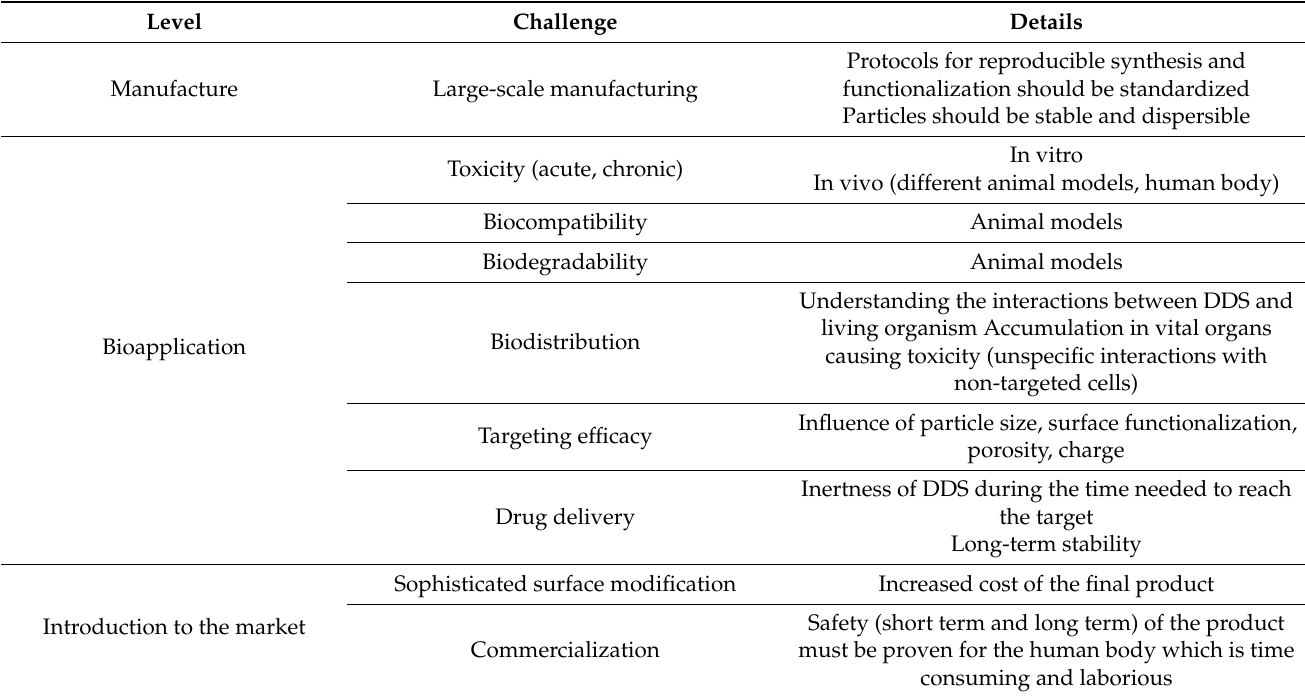
Table 6. Challenges related to the application of mesoporous material-based DDSs in